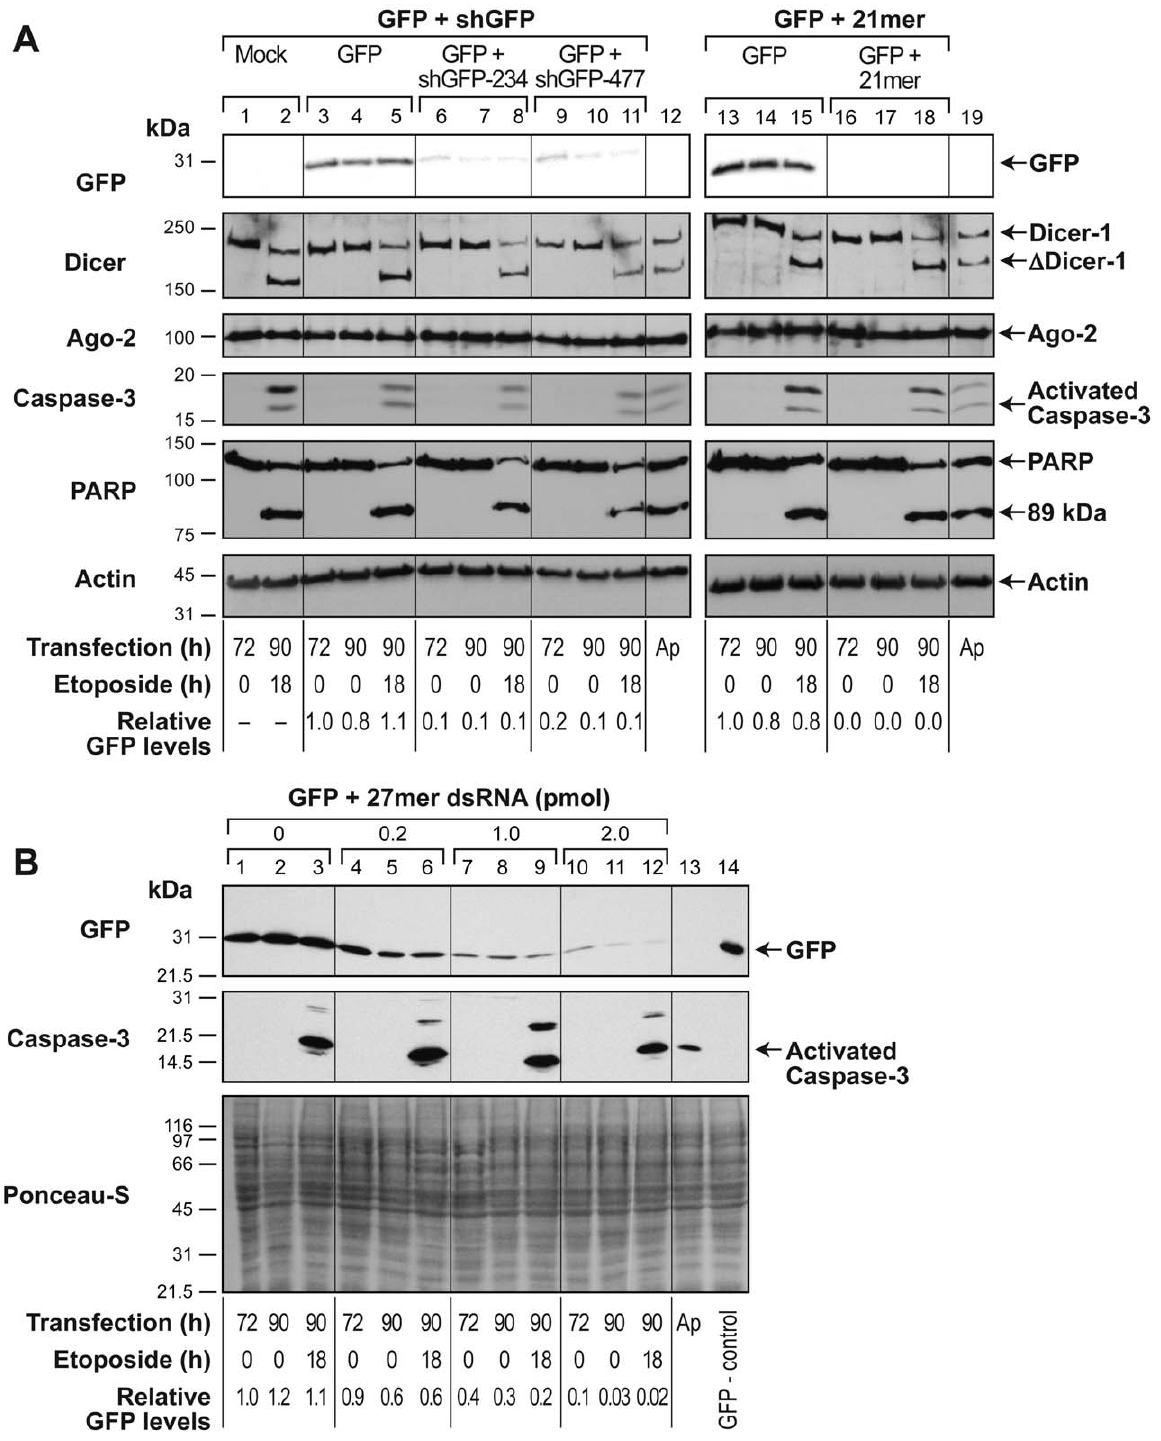
Figure 3. Persistence of transient RNAi of co-transfected GFP during apoptosis in GM637 cells. For examining apoptotic fate of transient RNAi of co-expressed GFP, GM637 cells were co-transfected with a GFP-expression vector and one of the following RNAi-inducing agents: ( A ) shGFP- 234, shGFP-477 and 21mer dsRNA or mock pCMV vector; or ( B ) Varying amounts (0, 0.2, 1.0 and 2.0 pmol) of 27mer dsRNA. At 72 h of knockdown, apoptosis was induced by treatment with 100 m M etoposide (or mock-control) for 18 h. Samples were harvested at 72 h (before apoptosis) or 90 h (after apoptosis) for immunoblotting for GFP, Dicer-1, Ago-2, activated caspase-3 and PARP, as specified for each panel. The relative GFP values were determined as described in Fig. 1A. For above panels, either Ponceau-S staining or actin immunoprobing served as loading controls and Ap refers to apoptotic cell extract prepared from etoposide-treated HL-60 cells. The experiments were repeated at least four times with identical results.